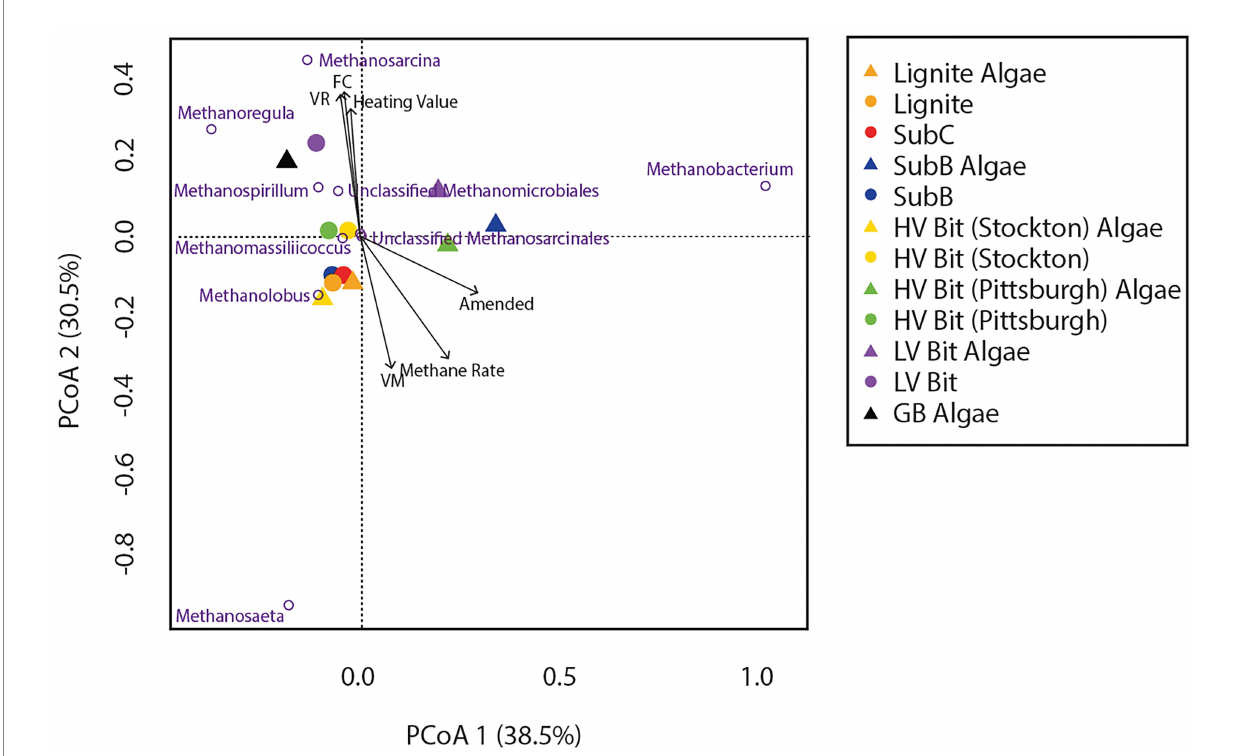
FIGURE 7 Principal Coordinate Analysis (PCoA) of non-transformed archaeal relative abundance based on OTUs combined by common phylotype with vectors representing significantly (or partially significant, p < 0.10) correlated coal composition and gas production